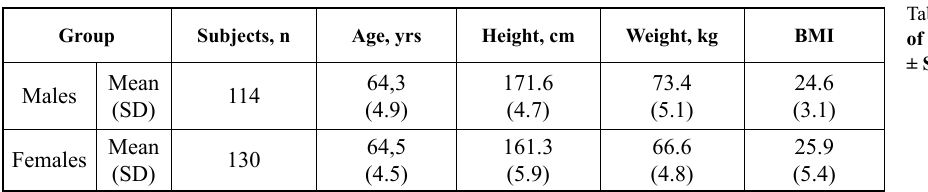
Table. Descriptive statistics of subjects. Values are means